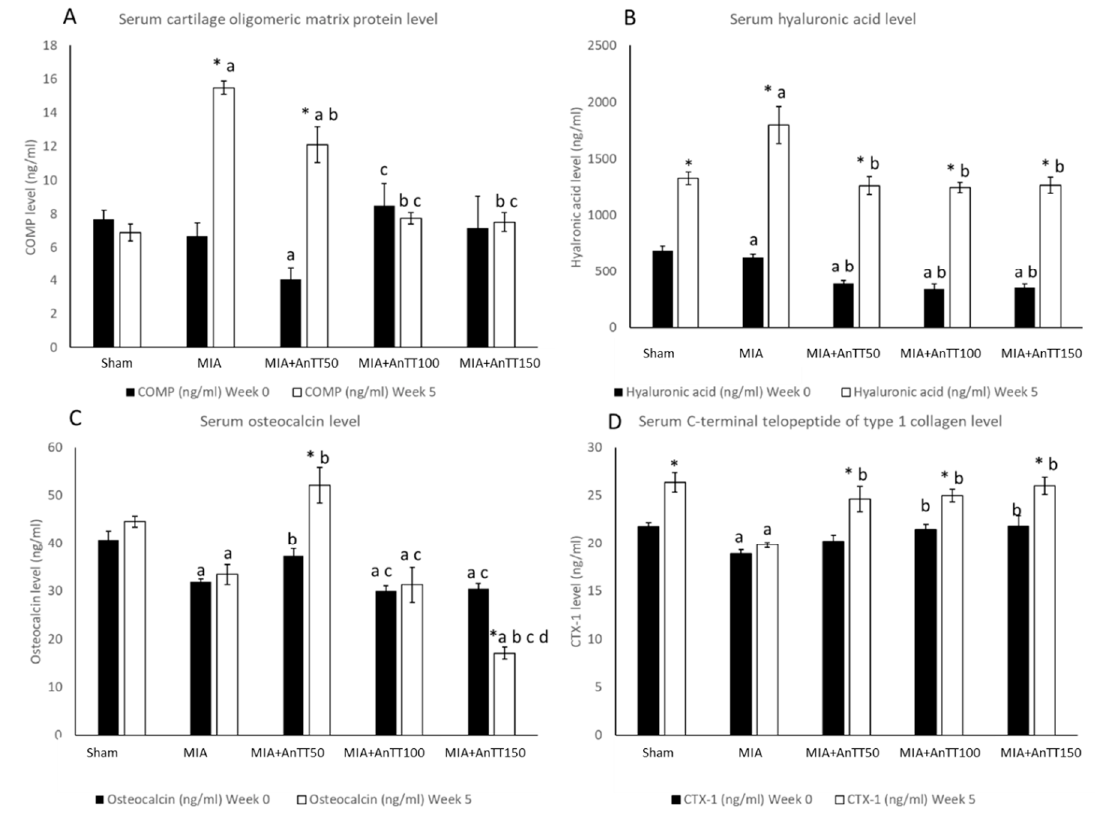
Figure 4. Joint and bone remodeling markers in the rats before and after treatment; serum cartilage oligomeric matrix protein level ( A ); serum hyaluronic acid ( B ); serum osteocalcin ( C ); Serum C-terminal telopeptide of type 1 collagen level ( D ). The data are shown as mean with standard error of the mean. The letter ‘a’ indicates significant difference versus the sham group; ‘b’ versus the MIA group; ‘c’ versus the AnTT 50 group; ‘d’ versus the AnTT 100 group; ‘*’ versus week 0. Abbreviation: AnTT, annatto tocotrienol.